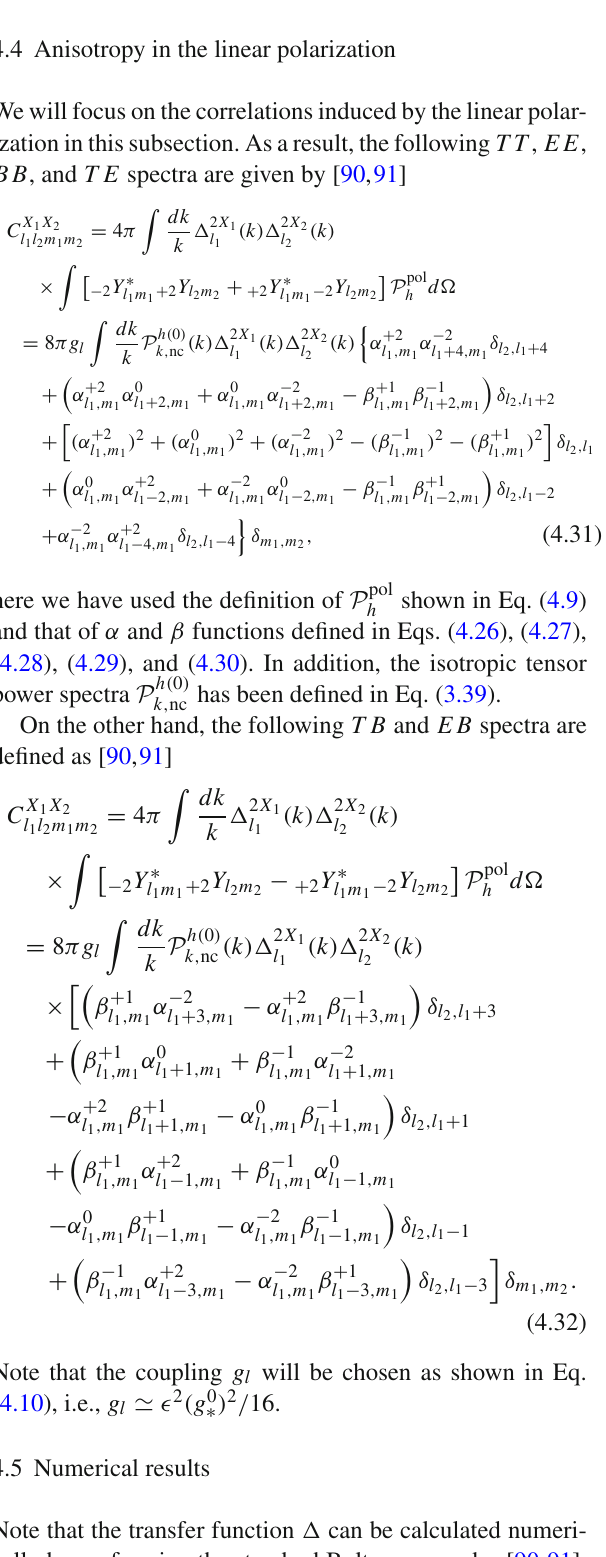
Fig. 1 (cid:19) as a function of c